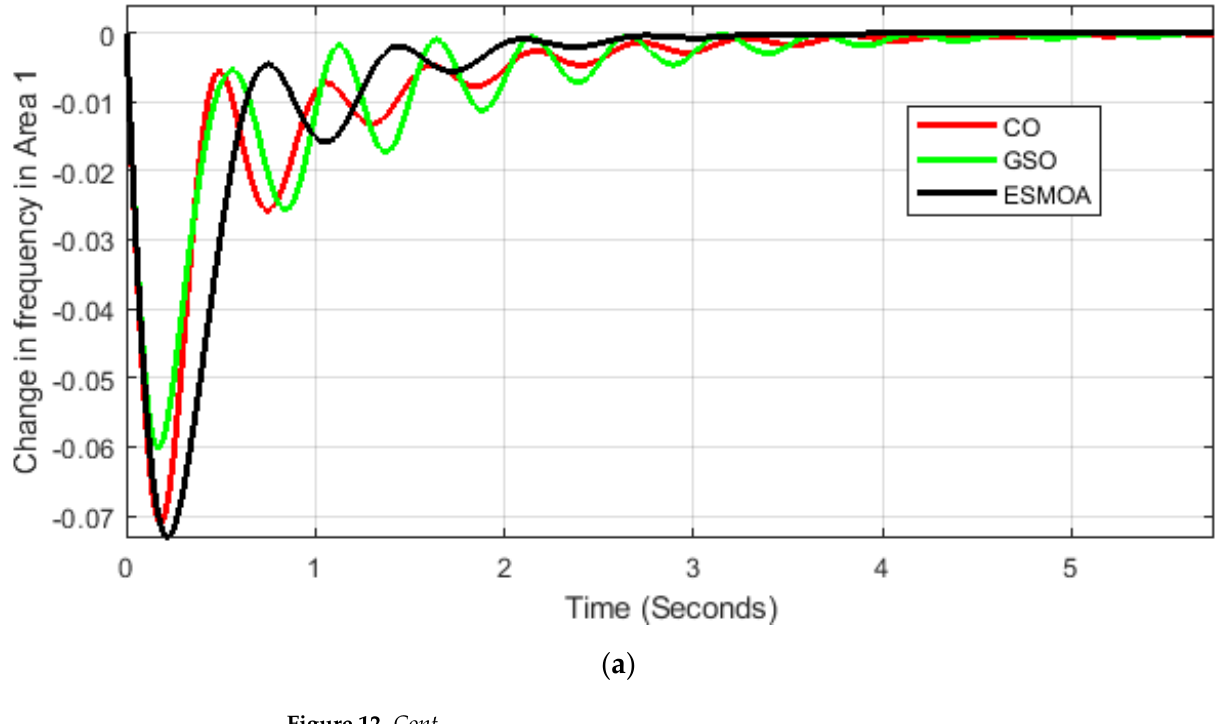
Figure 11. Converging characteristics of the suggested ESMOA, GSO, and CO techniques for Case 3.